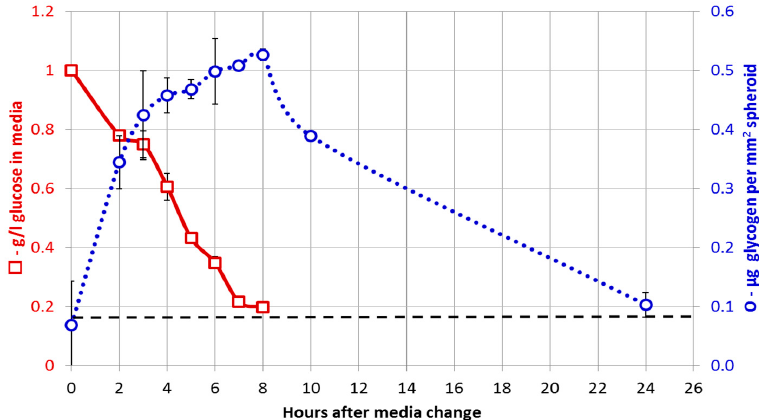
Figure 5. Relationship of glucose consumption from the media with the level of glycogen present in the spheroids. The amount of glucose in the spheroids prior to glycogen hydrolysis was negligible. Glucose starvation could unleash a number of changes in the cell, as initiated by the Glucose Regulated Proteins (GRP). These are typically found in the ER, often overexpressed in cancers and associated with aggressive growth and invasion [88]. Their first effect would be to increase ER stress and initiate the unfolded (or misfolded) protein response (UPR) [89]. In the UPR, GRP78 dissociates from three protein-folding quality sensors (IRE1, PERK, and ATF6) embedded in the ER membrane. These sensors activate the UPR signal transduction program, a negative feedback loop that alters gene expression to slow protein synthesis and the cell cycle (eventually leading to arrest in